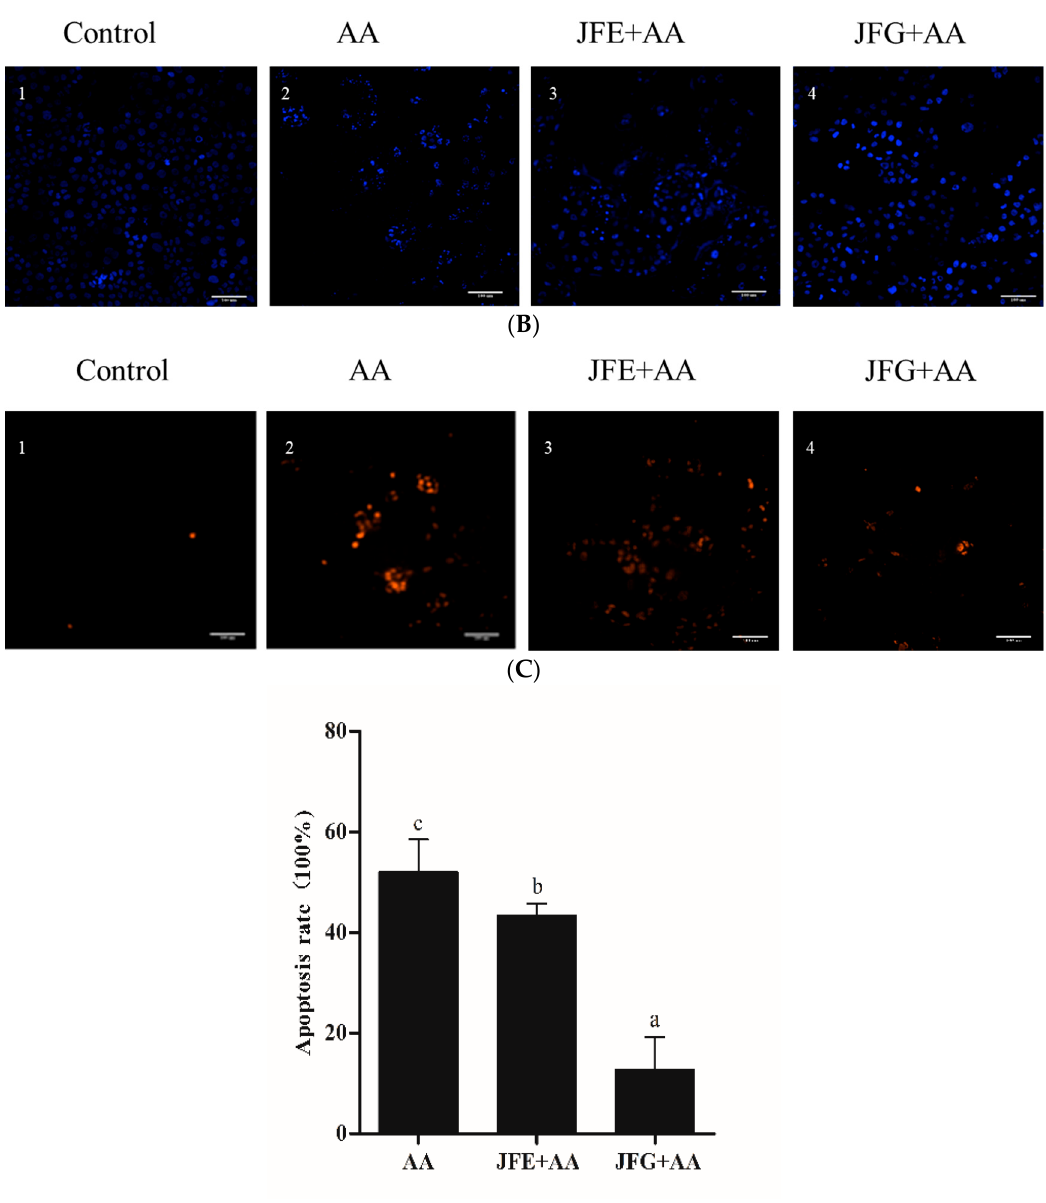
Figure 2. Effects of JFE and JFG on AA-induced Caco-2 toxicity. ( A ) Caco-2 cells were treated with 2 g/L AA for 24 h, with or without 2 mg/mL JFE or JFG for 24 h, cell viability was measured by 3-(4,5-Dimethylthiazol-2-yl)-2,5-diphenyltetrazolium bromide (MTT). ( B , C ) Caco-2 cells were treated with 2 g/L AA for 2 h, with or without 2 mg/mL JFE or 2 mg/mL JFG for 24 h, and then stained with Hoechst 33342 and PI and photographed using high-content analysis (HCA). Scale bars = 100 μm . ( D ) The JFE groups and JFG groups on apoptosis rate of Caco-2 cells for 24 h. The data was expressed as mean percent (mean ± standard deviations) and different letters in the bars within each group represent statistically significant differences ( p < 0.05).